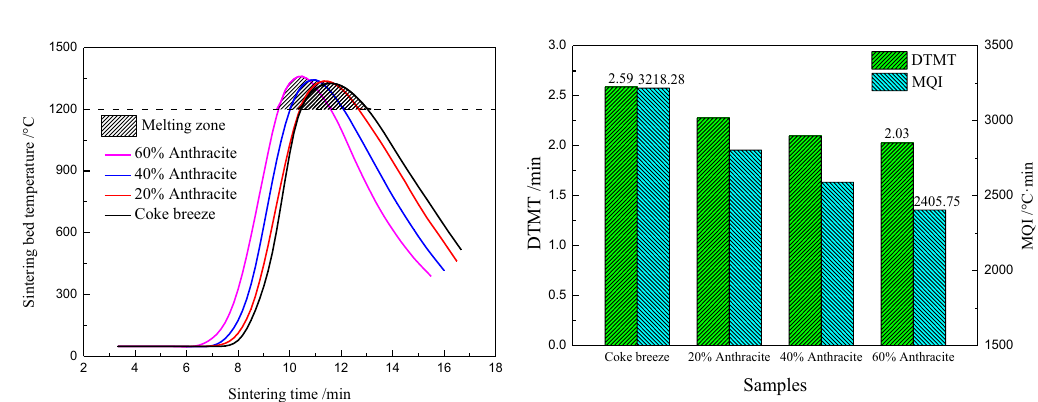
Figure 7. Effect of substituting anthracite for coke breeze on the thermal characteristic of the sintering bed (200 mm below the top of the sinter